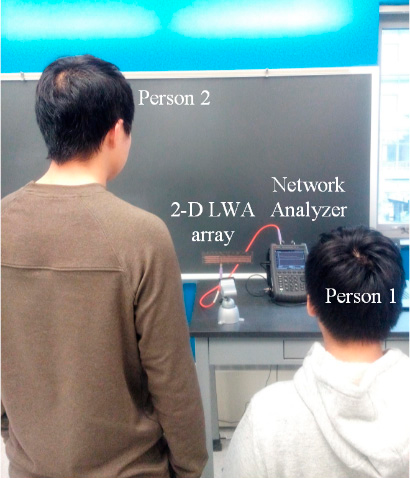
Figure 26. Experimental setup for multiple targets with different heights using 2D frequency-dependent beam scanning MTM LWA array [52].